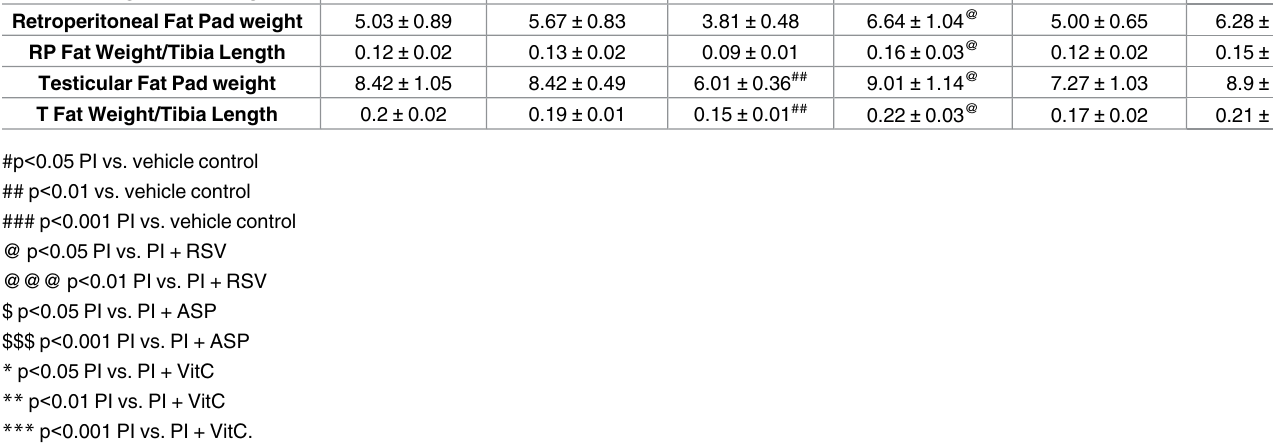
generally lower) (Table 4, S5 Data). The substrate combinations of pyruvate + malate and glu- tamate and malate activate dehydrogenases with the reduction of nicotinamide adenine dinu- cleotide (NADH) then feeding electrons into Complex I and down the thermodynamic cascade through the Q-cycle and Complex III of the electron transport system to Complex IV and O . Here RSV treatment significantly enhanced State 3 respiration compared to sole PI 2 treatment. However, ASP and VitC treatments resulted in a significantly lower ADP: O and RCR, respectively. We also assessed fatty acid-mediated respiration by employing palmitoyl– carnitine + malate as substrates but no significant effects were found in this instance.